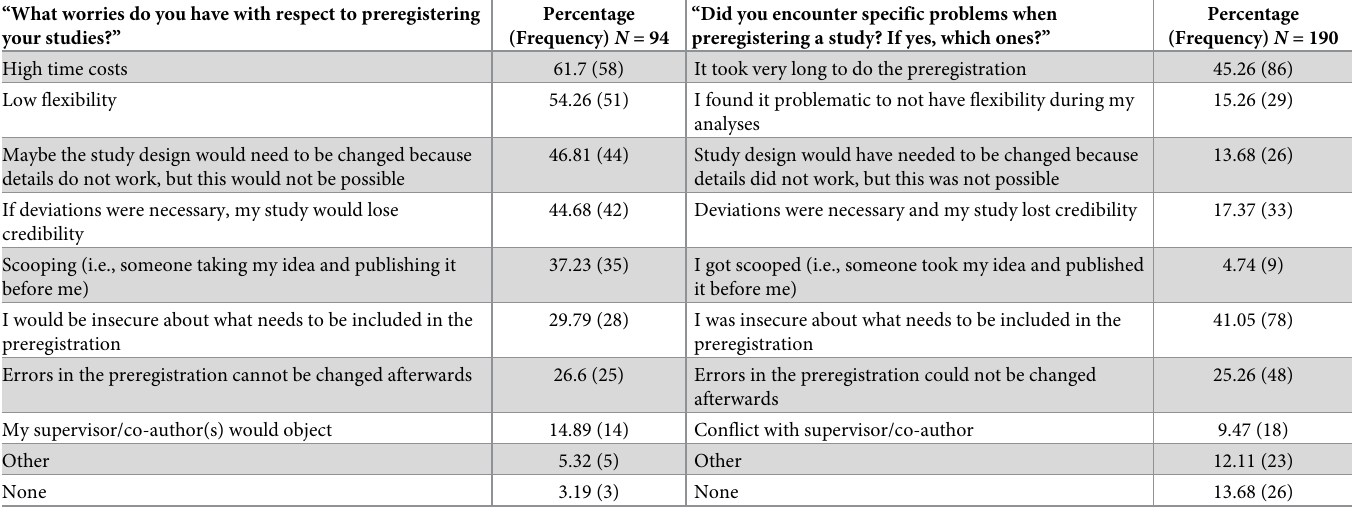
Table 2. Comparison of worries and actual problems regarding